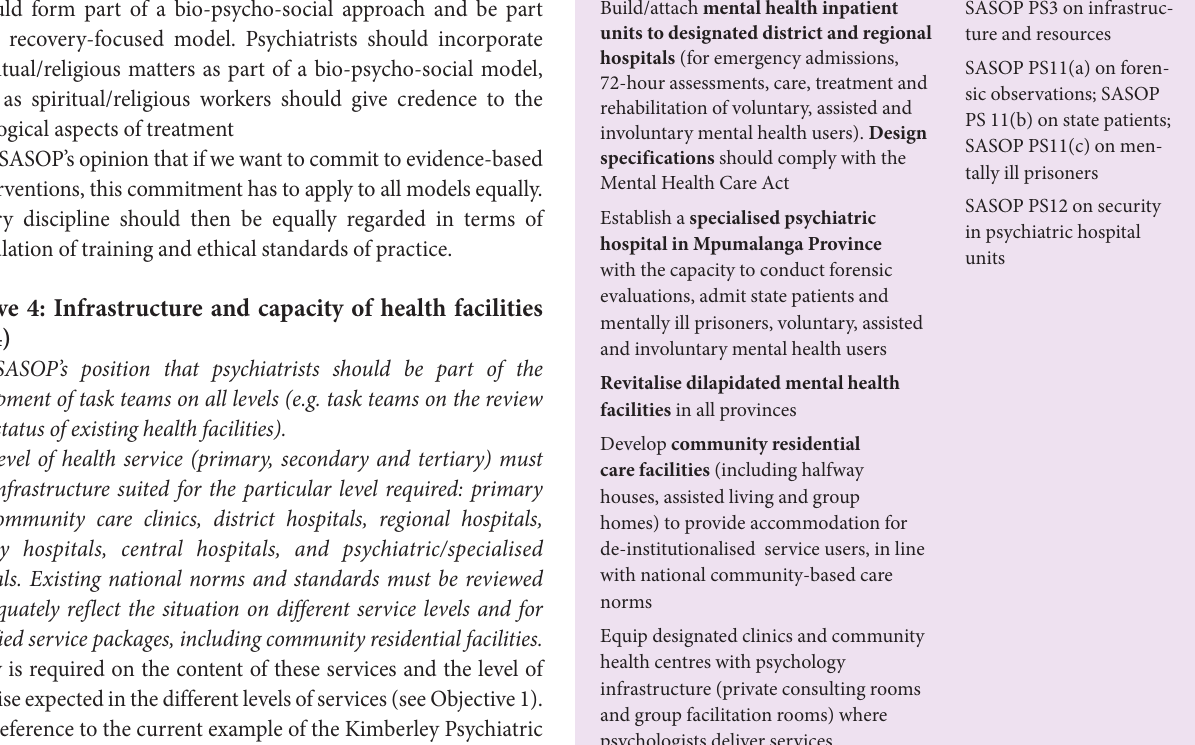
Table 4. Objective 4: Infrastructure and capacity of facilities Key